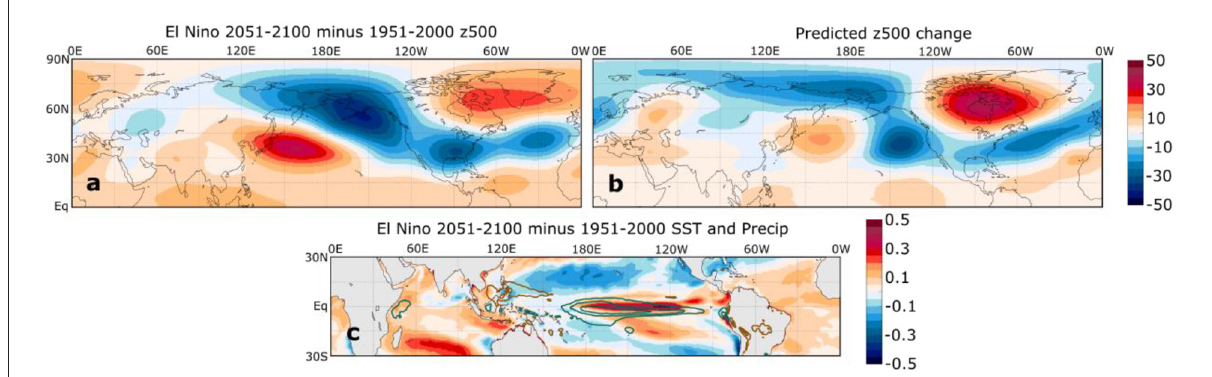
FIGURE9 (a) SPEAR ensemble mean change in DJF El Niño z500 composites (m) from 1951–2000 to 2051–2100. (b) The predicted z500 change corresponding to (a) based on the application of Equation (2) to the ensemble mean change in tropical SST anomaly composite ( c , color shading and units of ◦ C). Panel (c) also shows the change in ensemble mean precipitation composites (green contours for positive change and brown contours for negative change at an interval of 1mm day − 1